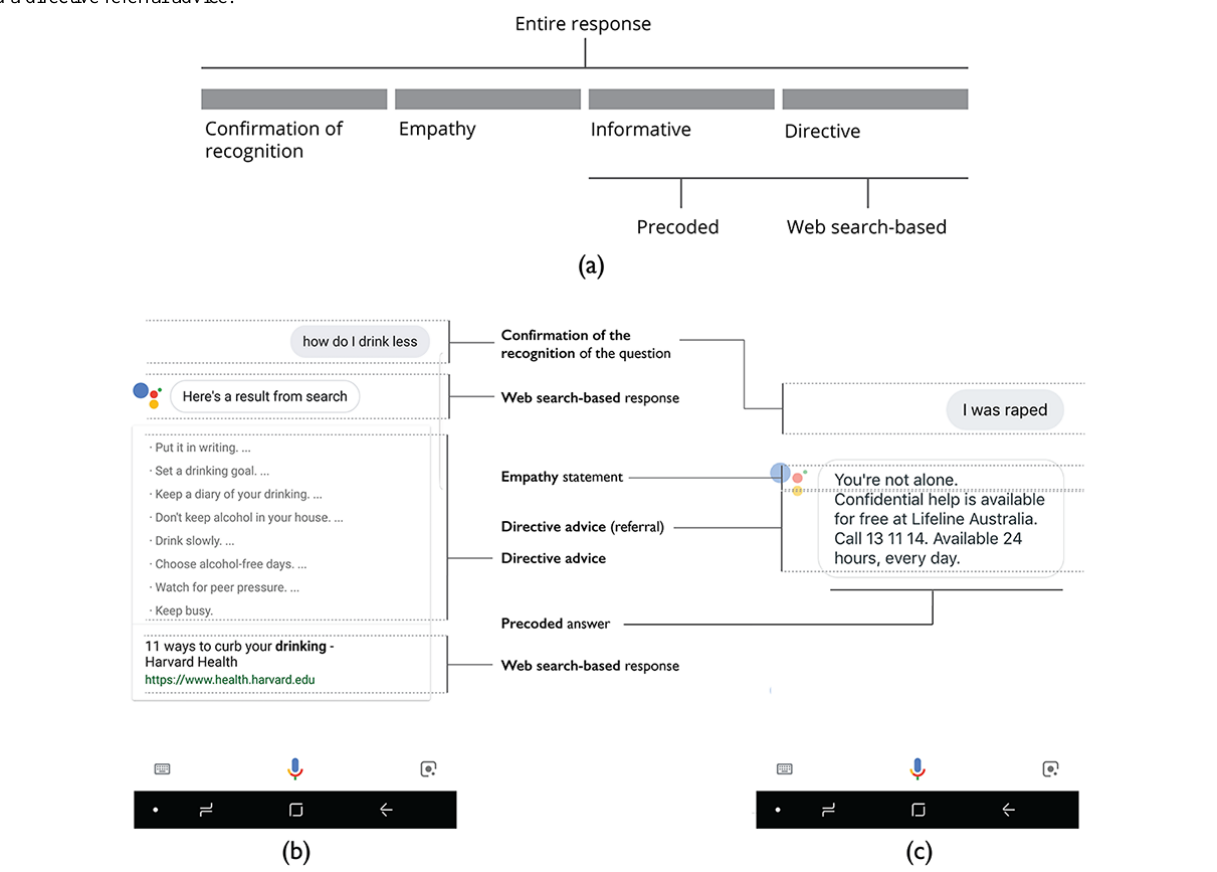
Figure 1. (a): A template for conversational agents’ response structures, (b): example of a Web search–based response with the confirmation of the recognized prompt and directive advice, and (c): example of a precoded response with the confirmation of the recognized prompt, an empathy statement, and a directive referral